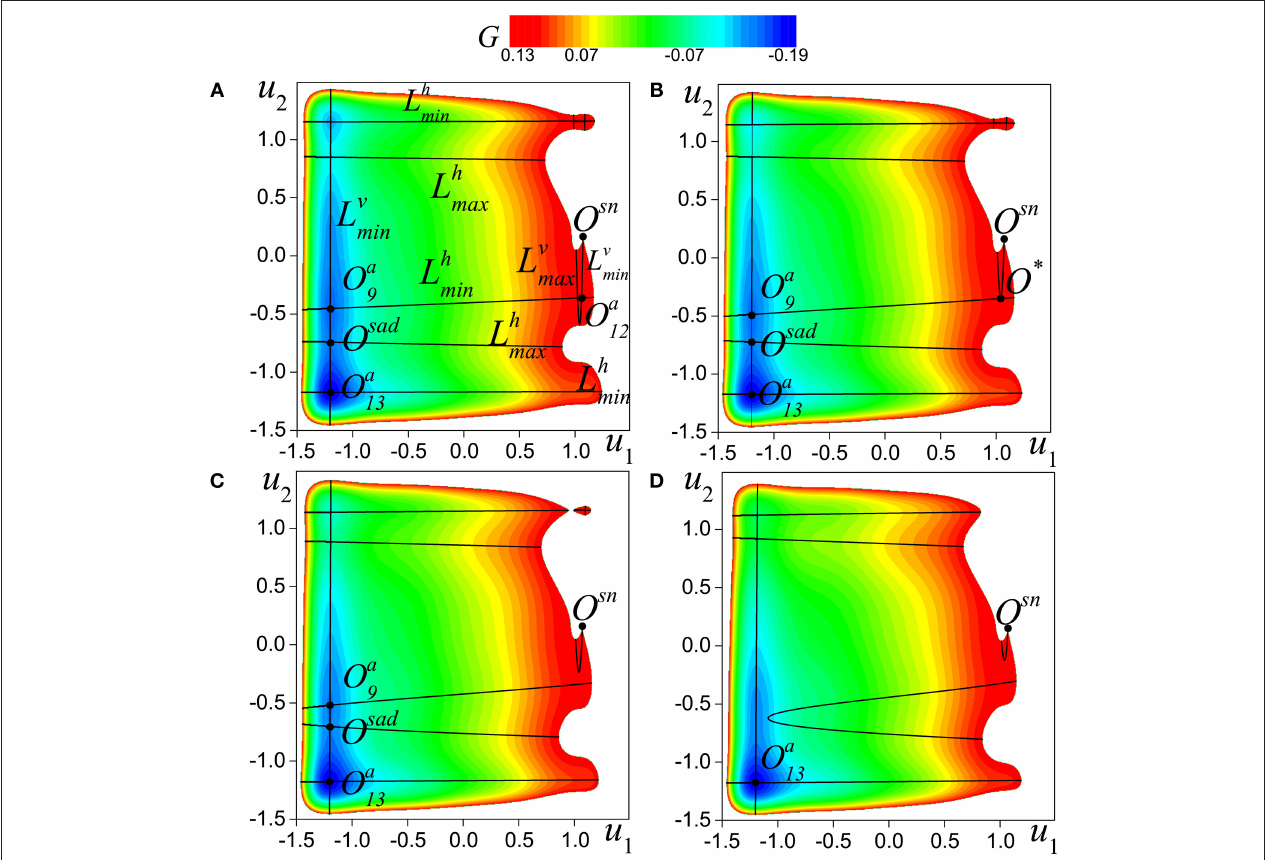
FIGURE 6 | A part of level map of the function G ( u 1 , u 2 ) taken at the saddle-node equilibrium state O sn ( u 0 1 , u 0 2 ) of the boundary S a 8 [i.e., when v 0 1 = f ( u 0 1 ) and v 0 2 = f ( u 0 2 )] for (A) d = 0.0075, ( u 0 1 = 1.07178, u 0 2 = 0.166426); (B) d = 0.0115, ( u 0 1 = 1.07178, u 0 2 = 0.16196); (C) d = 0.0150, ( u 0 1 = 1.07178, u 0 2 = 0.15809); (D) d = 0.0225, ( u 0 1 = 1.07178, u 0 2 = 0.0.14980). Levels depicted are below the one of O sn (marked by red color). White color marks region with higher levels of G . Curves L h max , L h min (respectively L v max , L v min ) defined by Equation (14) are minimum and maximum of G on variable u 2 (respectively variable u 1 ). O ∗ , O sad are additional saddle-node equilibrium states and O a 9 , O a 12 , and O a 13 are the node equilibrium states. Parameter values: a = 0.32, b = 0.79, and c =